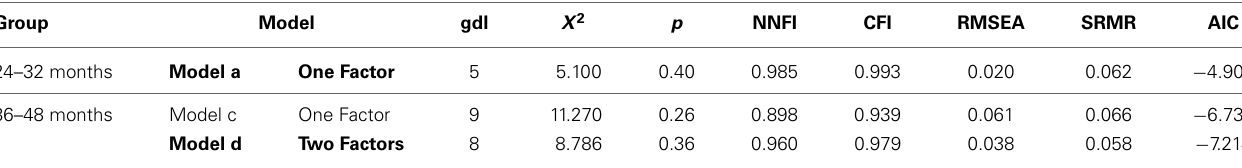
Table 3 | Goodness of fit